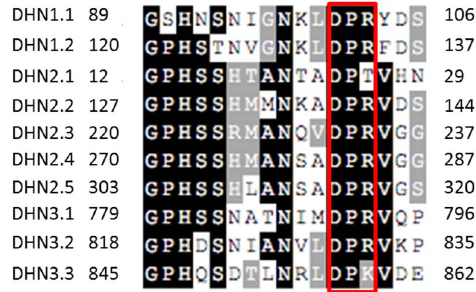
Figure 2. Alternative splicing of the AbDhn2 transcript. A: Electrophoresis gel of PCR products obtained after amplification of the AbDhn2 coding sequence using genomic DNA (lane g) or first-strand cDNA (lane RT) as template; Lane L: DNA ladder. B: Schematic representation of the splicing events leading to a and b forms of mature transcripts. Exons are indicated as black or hatched boxes.